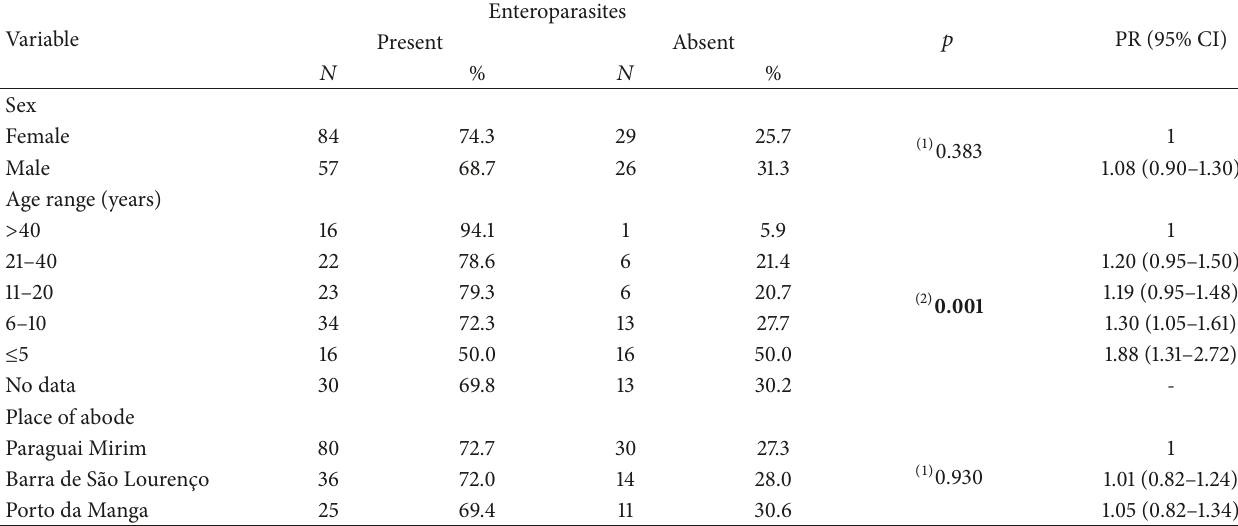
Table 1: Distribution of subjects, by presence or absence of enteroparasites, sex, age, and place of abode ( 𝑛 = 196 ).